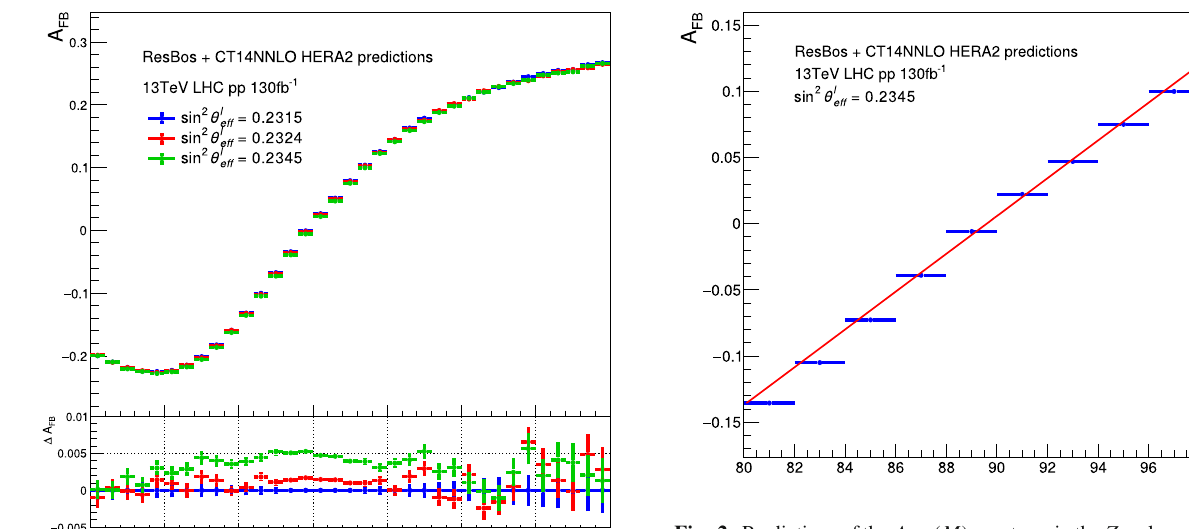
Fig. 2 Predictions of the A FB ( M ) spectrum inthe Z -pole region at the LHC, with a linear-fitting. Error bars are included for demonstrating the statistical Fig. 1 Predictions of A FB ( M ) as a function of the dilepton invariant mass M in pp → Z /γ ∗ → (cid:4) + (cid:4) − events at 13 TeV pp collisions, with different input values of sin 2 θ (cid:4) . The bottom panel is the bin-by- eff = 0 . 2315. bin difference with respect to the A FB ( M ) with sin 2 θ (cid:4) eff The error bar corresponds to the statistical fluctuation of the samples generated by using ResBos and CT14HERA2